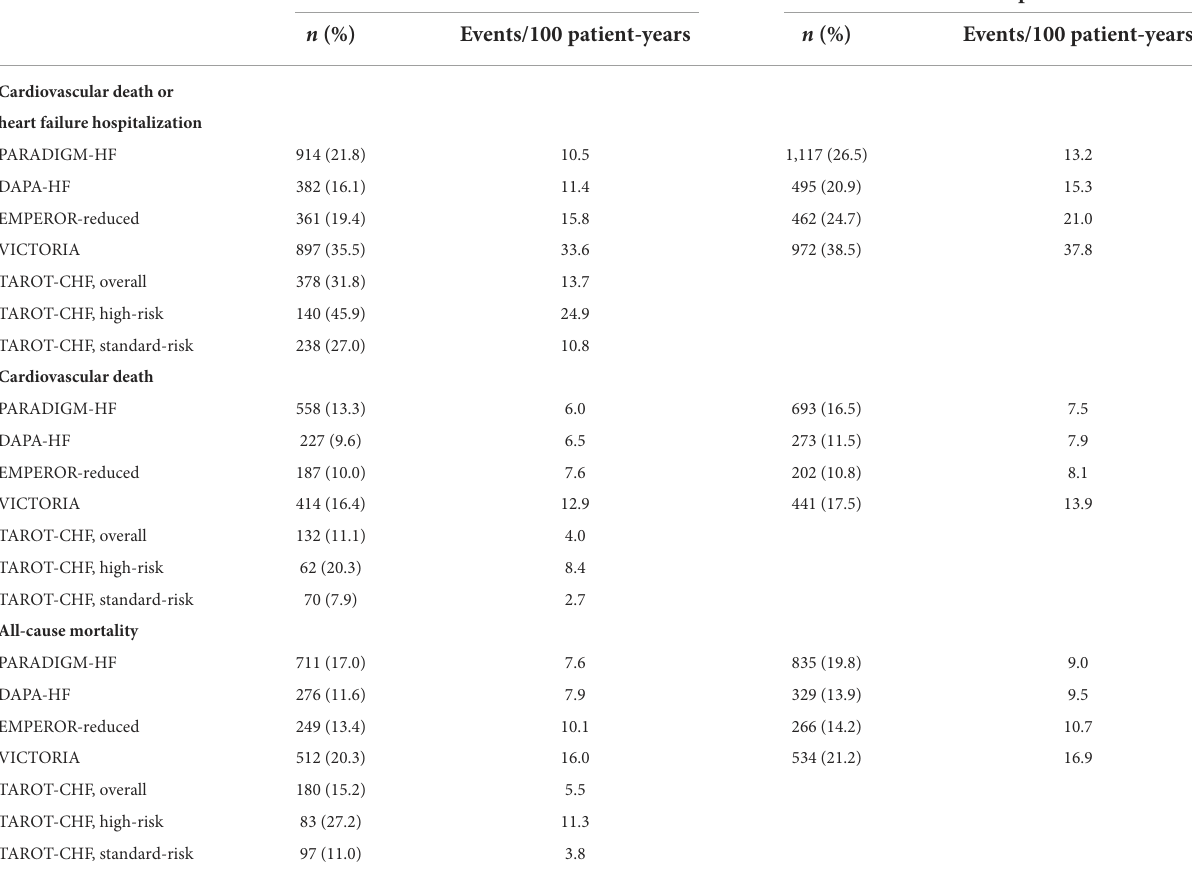
TABLE 2 Comparisons of outcomes among different randomized controlled trials and the current